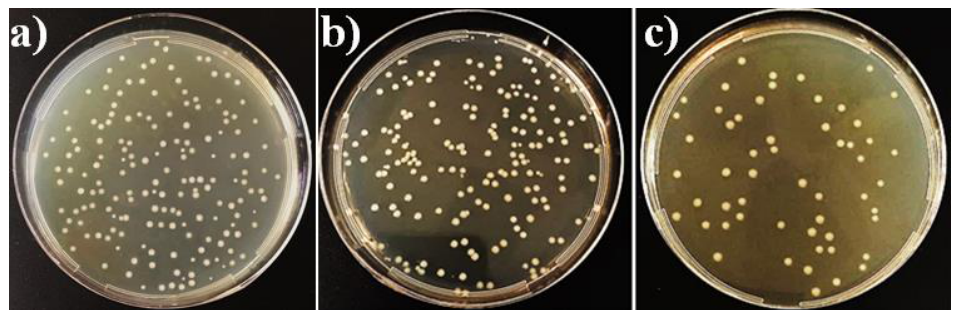
Figure 9. Culture plate photographs of E. coli after re-cultivation: ( a ) cp-Ti substrate, ( b ) the MAO and ( c ) Cu-based MAO surface cultivation.